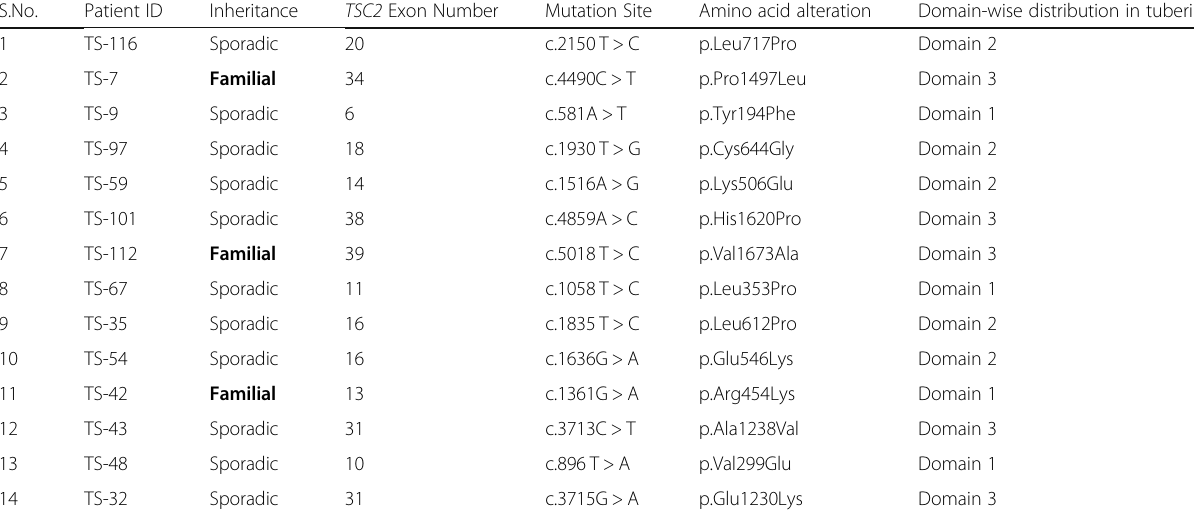
Table 1 List of 14 novel missense TSC2 mutations